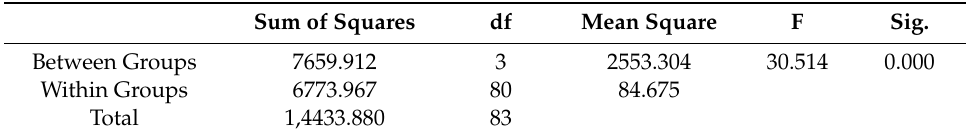
Table A1. ANOVA Results and a Post Hoc